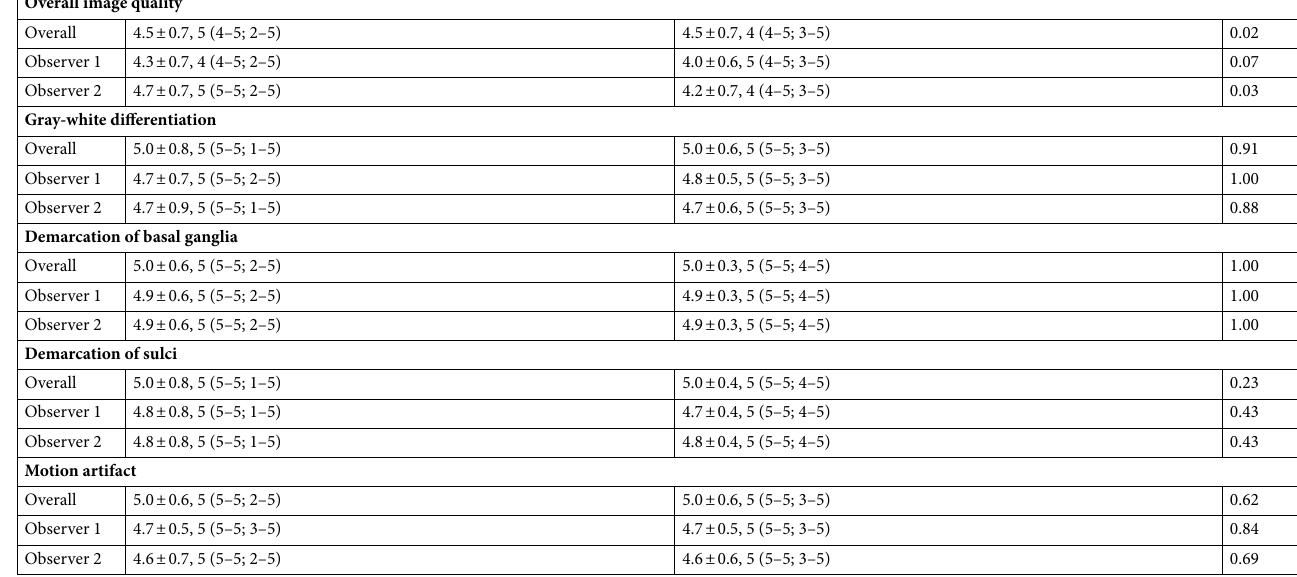
Table 4. Qualitative image analysis. MPRAGE magnetization-prepared rapid gradient echo, SD standard deviation, wave-CAIPI wave-controlled aliasing in parallel